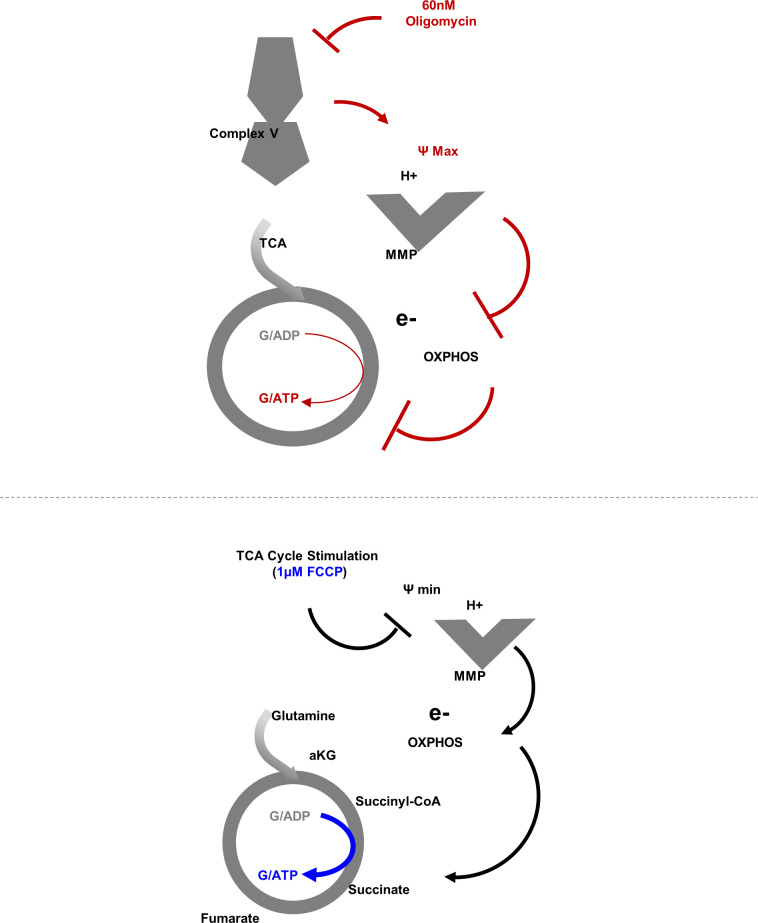
Schematic of the suggested model; respiratory restriction through inhibition of complex V by oligomycin leads to increase in mitochondrial membrane potential and decreased electron flow.(Top) Decreased electron flow leads to inhibition of TCA cycle and substrate-level phosphorylation since that these processes are coupled. (Bottom) Schematic of the suggested model for rescuing respiration restricted primed CD8+ T cells. FCCP treatment decreases mitochondrial membrane potential which allows both electrons and the TCA cycle to reflow, restores GTP/ATP production in the matrix by the substrate-level phosphorylation.